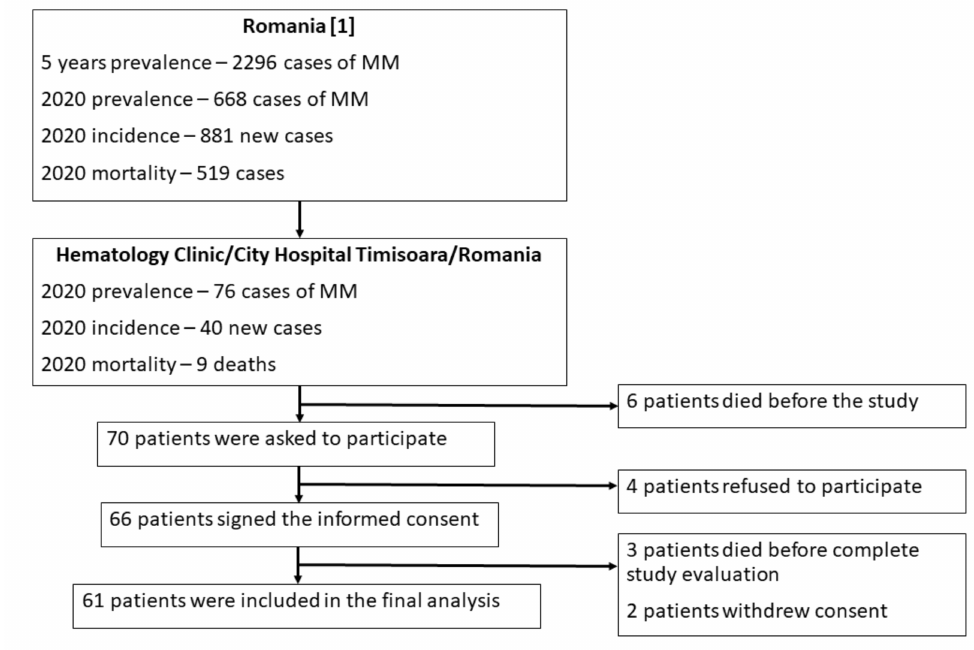
Figure 1. Study flow